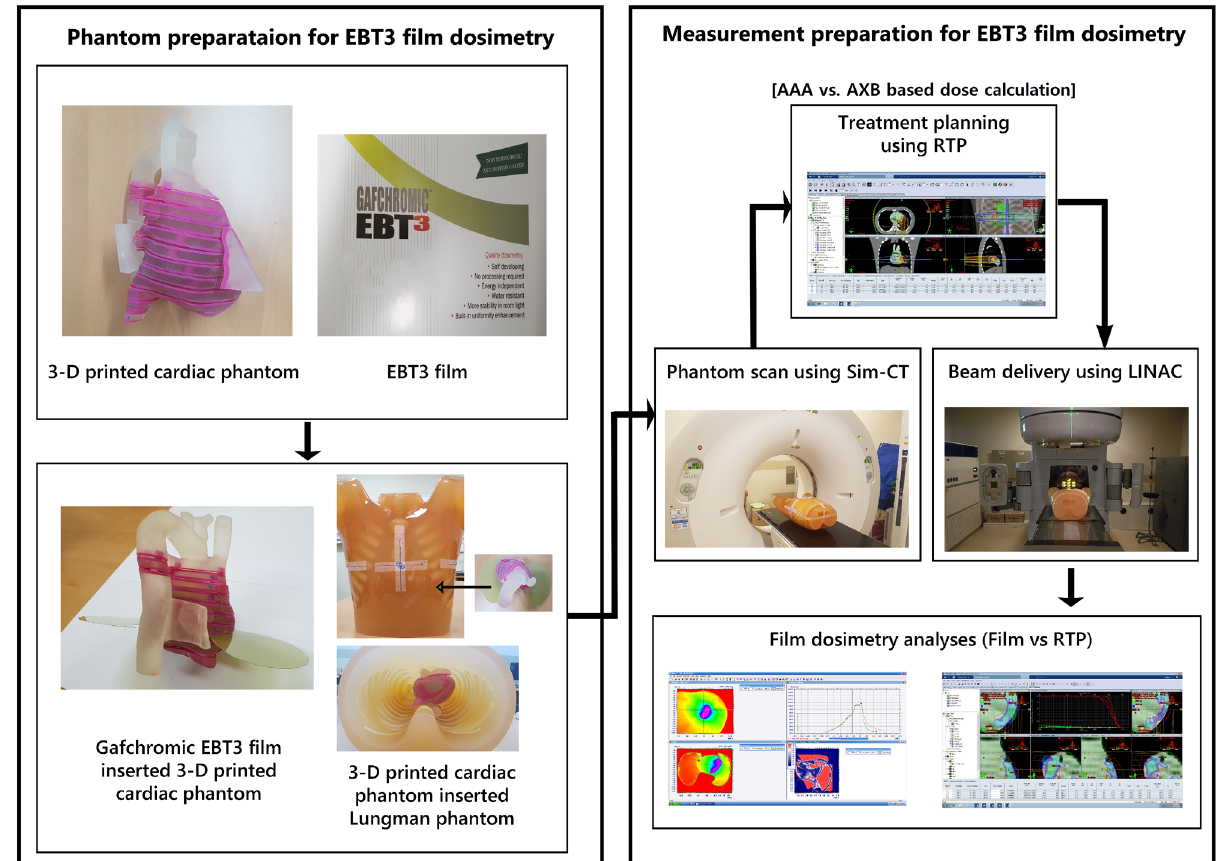
Figure 3. Overall procedures of the experiments and analysis for the